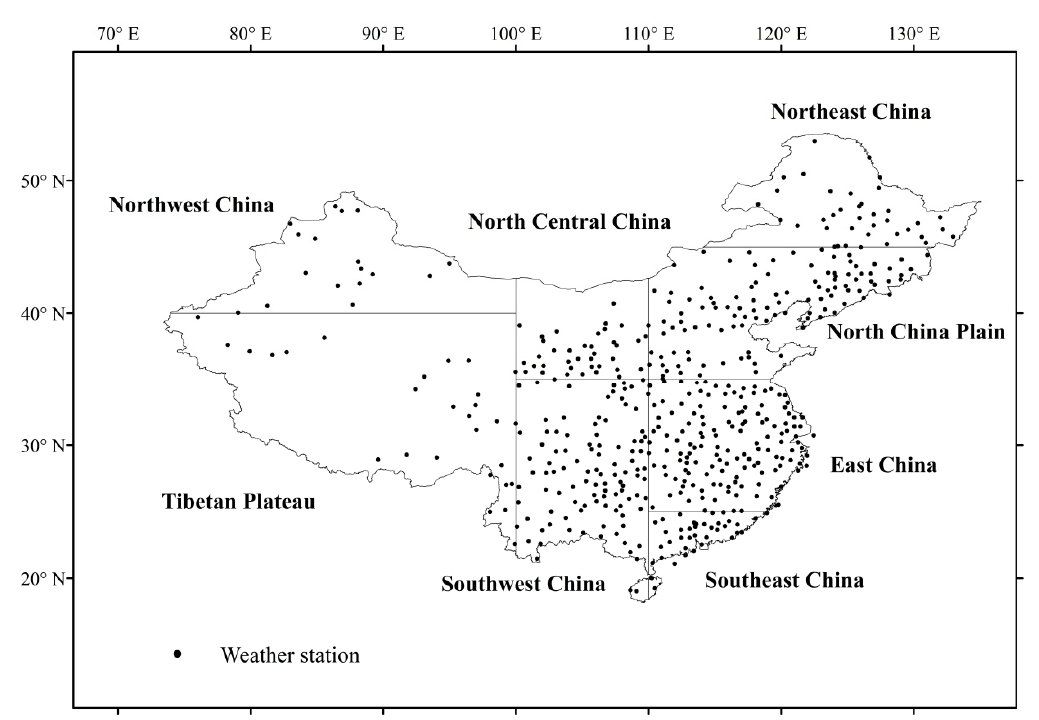
Figure 1. Geographical distribution of the 515 weather stations and eight climatic regions in China.